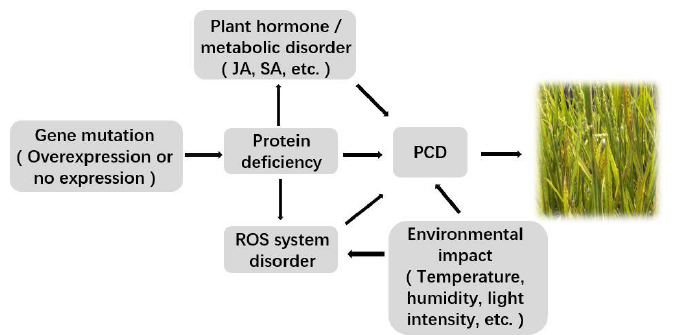
Figure 1. Mechanism of rice lesion mimic occurrence. (The mechanism of plant lesion formation is varied and complex and mainly regulated by genes such as disease resistance, death regulation, and basic metabolic enzymes; plant defense signaling molecules and external environmental factors also play important roles in forming lesions. All the arrows indicated positive regulatory relations).